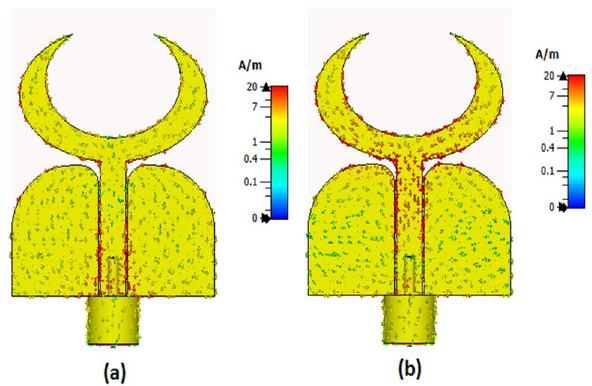
Figure 4. The current distribution outcomes ( a ) @ 4.5 GHz, ( b ) @8.5 GHz.